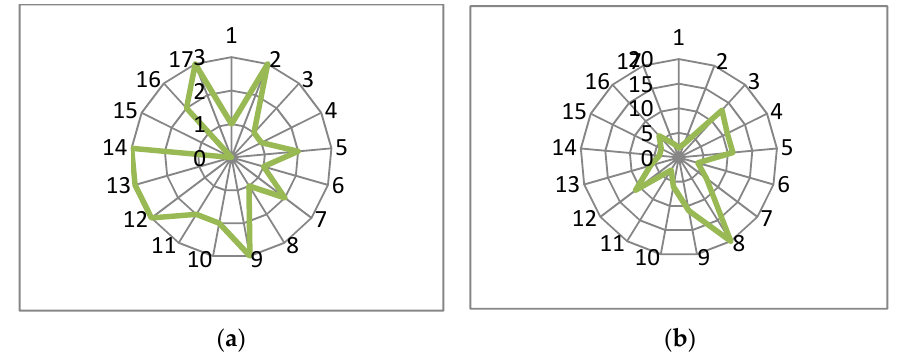
Figure 3. ( a ) Hungary’s level of achievement; ( b ) Hungary’s companies’ coverage of the SDGs (incident rate in COPs).